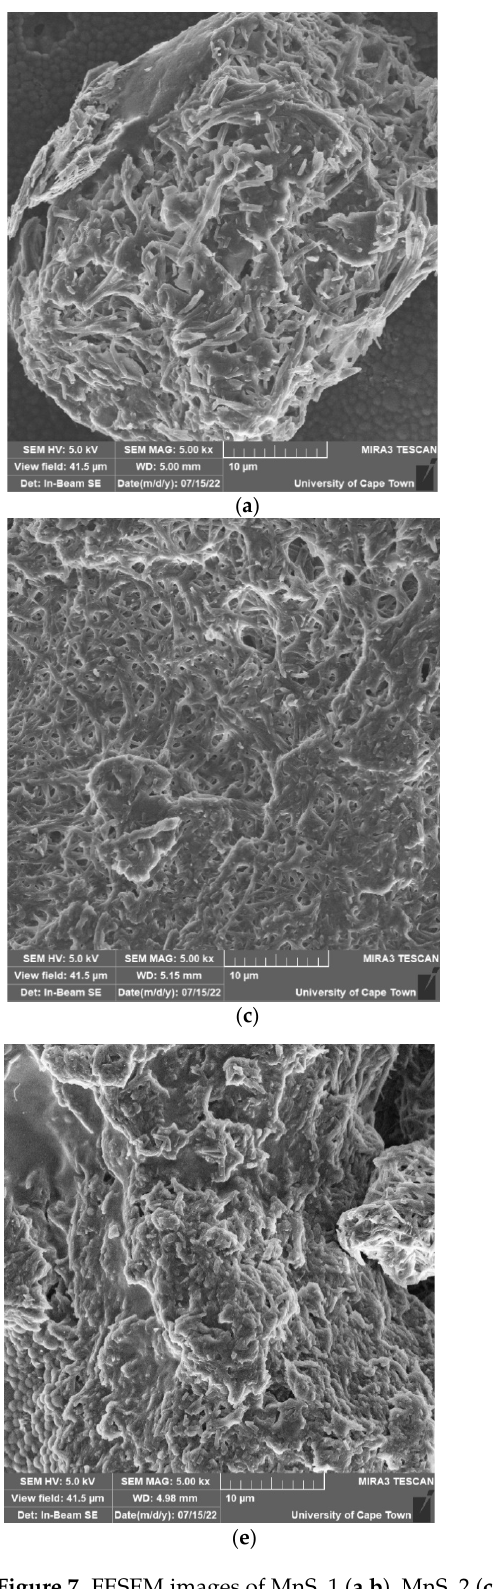
Figure 8. EDS spectra of MnS_1 ( a ), MnS_2 ( b ) and MnS_3 ( c ) nanoparticles. In this study, we employed a single-source precursor using MnCl ₂  4 H ₂ O and TOPO as coordinating solvents in a single step to form γ -MnS nanoparticles, representing a cost-